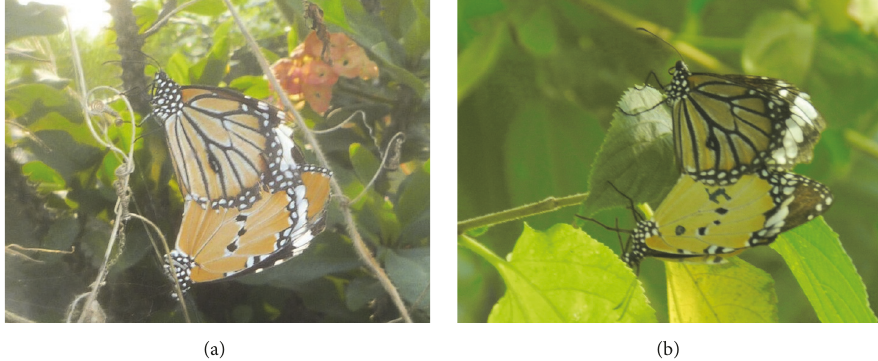
Figure 2: Interspecific mating in D. chrysippus and D. genutia. (a) First occurrence in 2015 and (b) second instance in 2016.